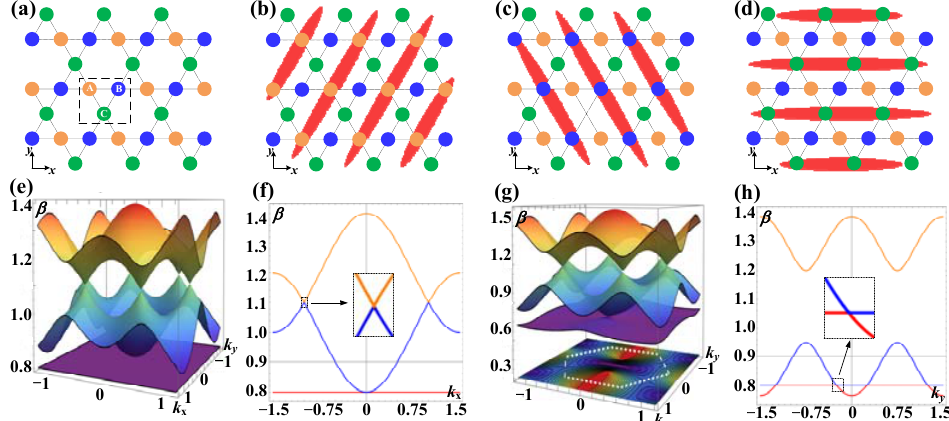
Figure 2. ( a ) The geometric sketch of a Kagome lattice. Three inequivalent sublattices (A, B, and C) are indicated by orange, blue, and green in the dotted box. ( b – d ) depict the spatial arrangements of the periodic one-dimensional coupling field (red fringes) that covers different sets of sublattices in the Kagome lattice inside the 85 Rb cell in x-y plane. ( e ) Band structure of the Kagome lattice corresponding to ( a ). ( f ) The flatband and traditional type-I Dirac cones appear at β = 0.8 and 1.1, respectively, in the cross-sectional graph of ( e ). ( g ) The band structure of the modulated Kagome lattice corresponding to ( d ). ( h ) Cross-sectional graph of ( g ), and the type-III Dirac points